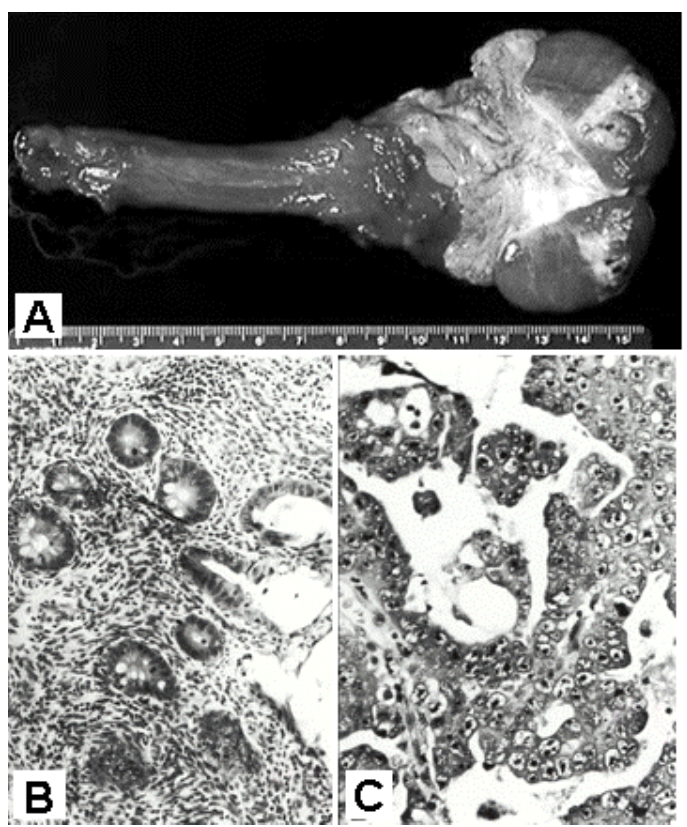
FIGURE 2 . (A) Gross image of testicular tumor. (B) Primary tumor with mature enteric glands containing goblet cells (hematoxylin and eosin; original magnification 25 × ). (C) Right ventricular thrombus with high-grade carcinoma organized in trabecular and papillary formations, consistent with embryonal carcinoma (hematoxylin and eosin; original magnification 50 ×